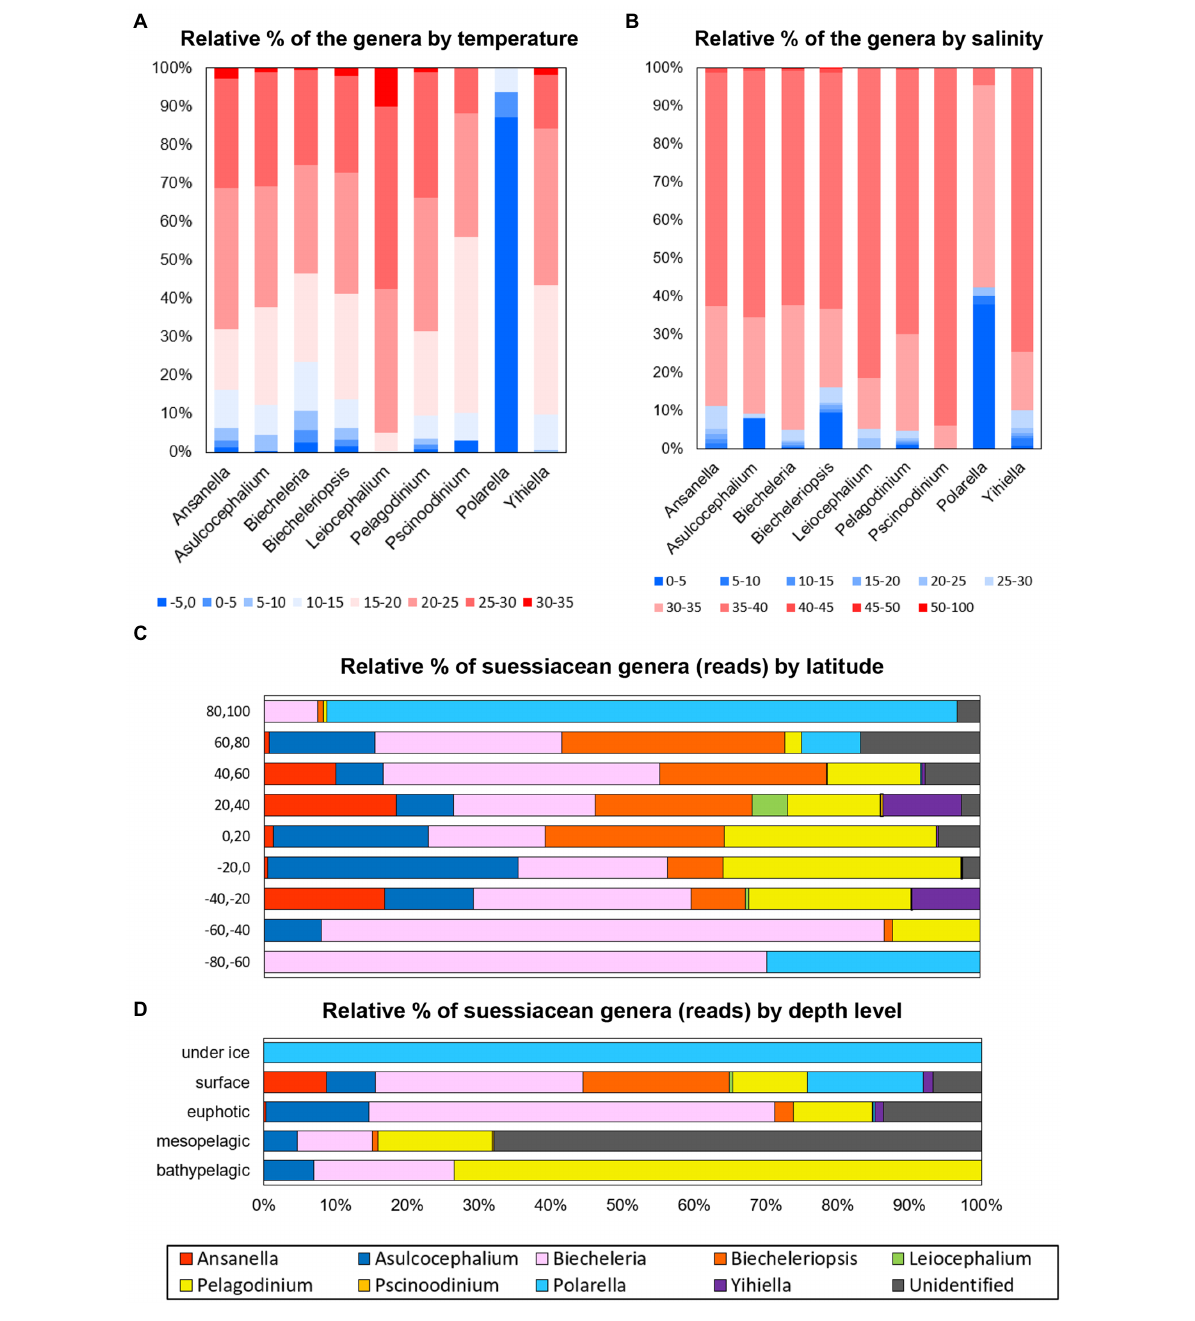
FIGURE 3 Relative read abundance of each genus (family Suessiaceae) according to (A) water temperature and (B) salinity of the surveyed samples. The color scheme represents the water temperature ( - 5–35 ° C) and salinity (0–100 psu). Relative read abundance of each genus classified by (C) horizontal (i.e., latitude) and (D) vertical (i.e., water depth)